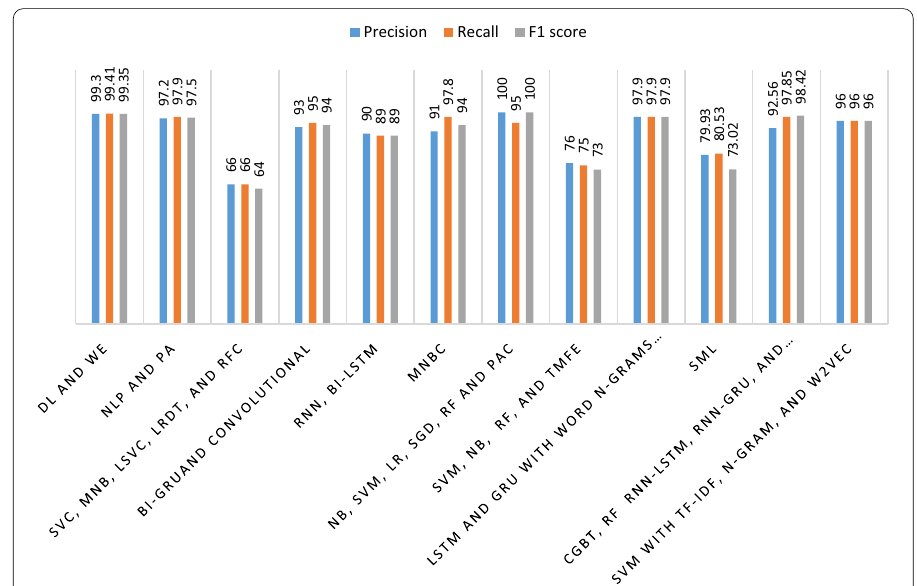
Fig. 1 Performance of the implemented